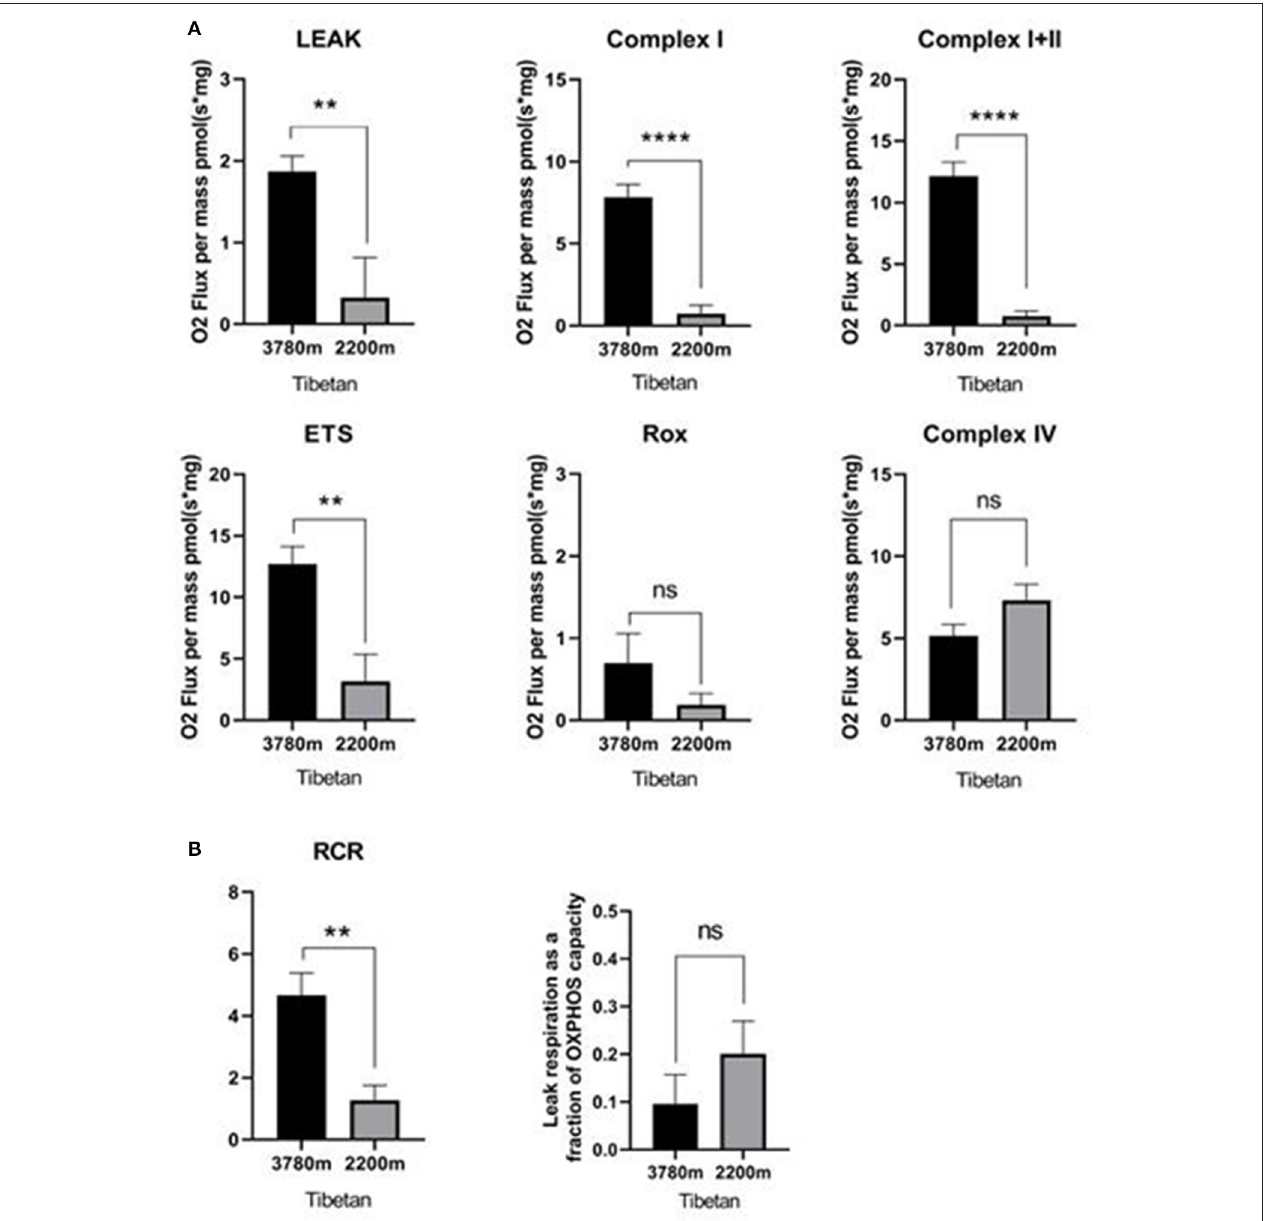
FIGURE 2 | Respiration in high- vs. lower-altitude Tibetan groups. (A) Oxidative phosphorylation (OXPHOS) through mitochondrial complex I, complex I + II, non-phosphorylating (LEAK) respiration, and electron transfer system (ETS) maximum capacity respiration were statistically significantly increased in high-altitude Tibetan group compared to lower-altitude Tibetan group. Non-ETS respiration (ROX) and OXPHOS through mitochondrial complex IV did not change with altitude. (B) The respiratory control ration (RCR) was statistically significantly increased in the high-altitude Tibetan group compared to the lower-altitude Tibetan group. But the LEAK/ETS was not significant change. ns: p ≥ 0.05; ** p < 0.01; **** p < 0.0001. Statistical significance was determined via Student’s t -test. Columns represent means and error bars present standard errors of the mean.